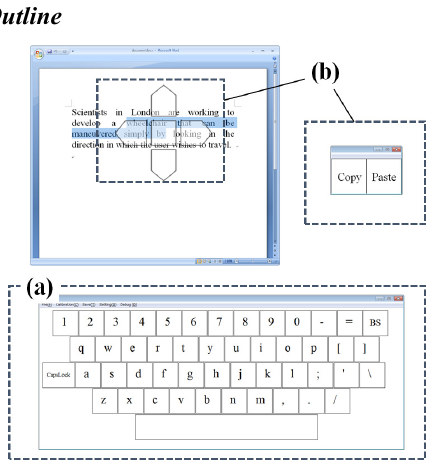
Fig. 5. Screenshot of the proposed